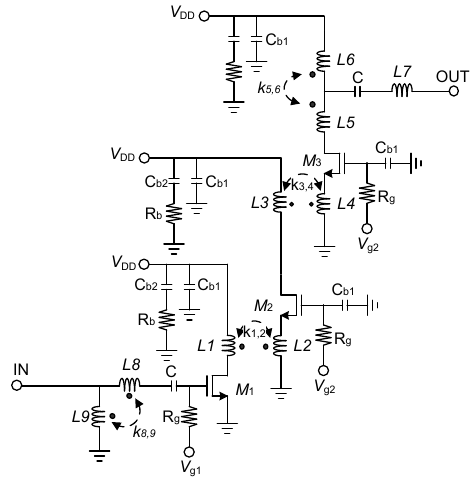
Figure 2. Circuit schematic of the V-band magnetic coupled triple-cascode LNA